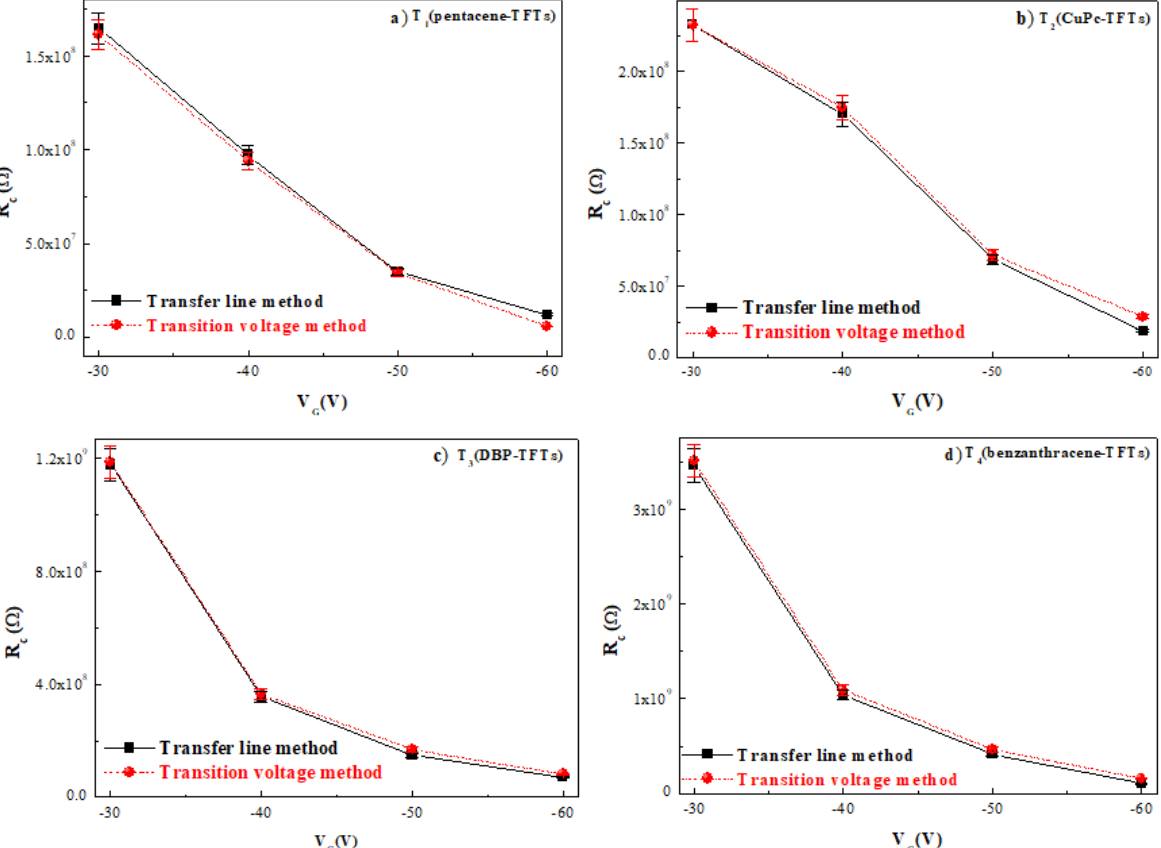
Figure 6. Comparison of the obtained values by the transition voltage method (circle) and the transfer line method (full square) of the contact resistance as a function of the V G of all fabricated OTFTs in linear regime: ( a ) for T 1 (pentacene ‐ TFTs), ( b ) for T 2 (CuPc ‐ TFTs), ( c ) for T 3 (DBP ‐ TFTs) and ( d ) for T 4 (benzanthracene ‐ TFTs).